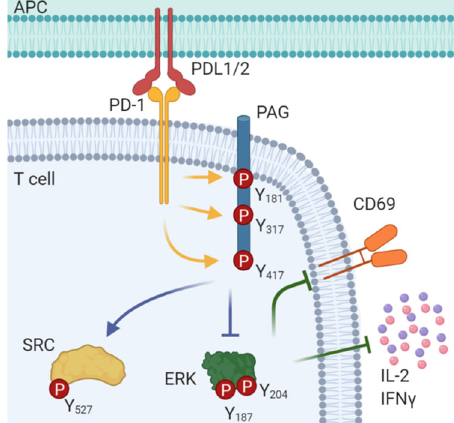
Fig. 8 PAG is a mediator of PD-1 signaling. A model of the role of PAG in PD-1 signaling. As T cells are stimulated through the T cell receptor and PD-1 is bound to PDL1 or PDL2 PAG is phosphorylated at Y181, Y317, and Y417 and plays a necessary role in the inhibition of T cell were passaged prior to storage and thawed and passaged twice prior to implantation for all described tumor experiments. All cell lines were determined to be free of mycoplasma (Lonza).